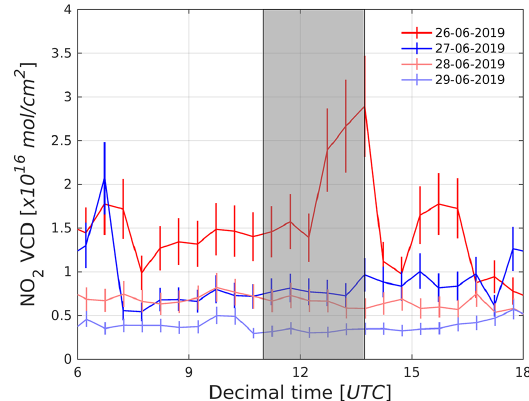
Figure 11. Tropospheric NO 2 VCD diurnal variation between 80 ◦ sunrise and sunset, retrieved from the Uccle MAX-DOAS station on 26–29 June 2019. The instrument is pointed towards the Brussels city centre (35 ◦ N). Vertical error bars indicate the NO 2 VCD error for each retrieval. The grey zone indicates the merged APEX flight time (11:00–13:44UTC) for 26 to 29